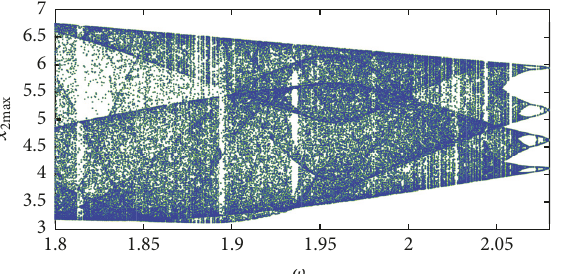
Figure 6: Bifurcation of the TDNHPS with time delay 𝜏 .